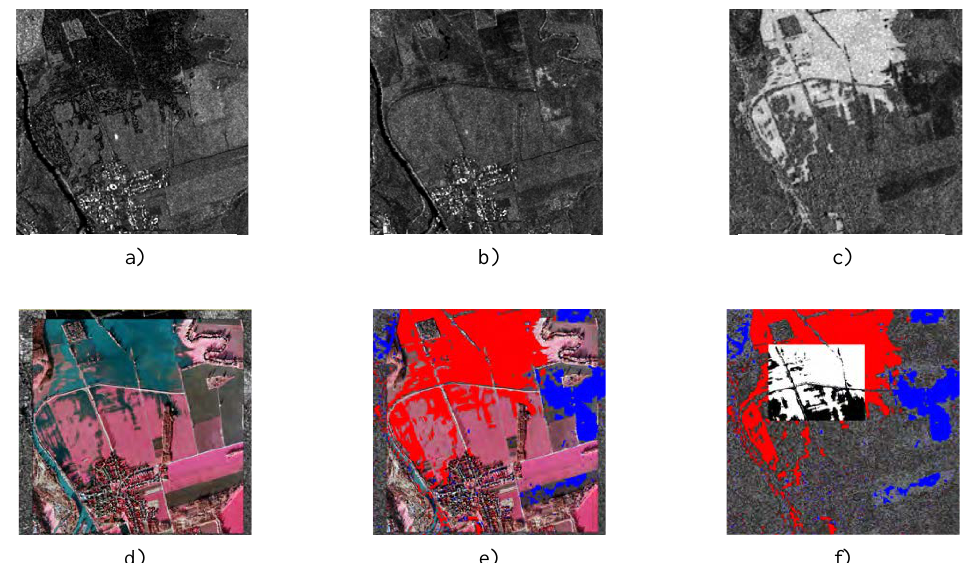
Figure 2 : Study area of Halle, Germany. Subsets of TerraSAR-X amplitude data (© DLR 2013) of a) 17/01/2011 and b) 08/02/2011, c) intensity ratio image between b) and a), d) co-registered aerial RGB image data, e) classification based on the hypothesis test and the graph-cut algorithm, g) classification with the binary mask derived from d). In e) and f) positive- and negative-change are shown in red and blue colors, no-change is transparent.